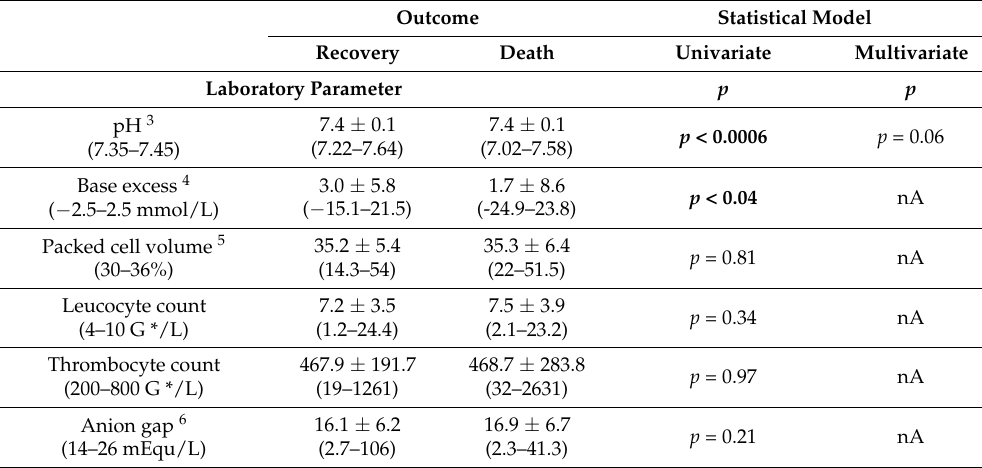
Table 6. Distribution of laboratory findings on the day of admission in 672 cows diagnosed with left displacement of the abomasum (LDA) according to the outcome (“recovery” or “death”). Ranges and physiologic values for laboratory parameters are given in brackets; values are given as mean and standard deviation (SD). For probability of recovery, results with a p -value < 0.05 were considered statistically significant and are printed in bold letters. Results are given for both the univariate and the multivariate model. All parameters with a p -value < 0.2 were included in the multivariate model; all other parameters are indicated as not applicable